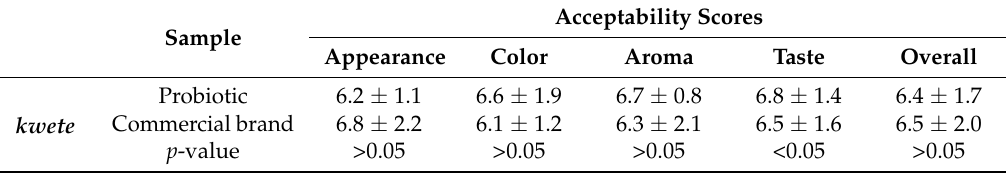
Table 1. Comparison of the consumer acceptability scores of probiotic kwete produced by L. rhamnosus yoba 2012 and S. thermophilus C106 with a commercial brand on a 9-point hedonic scale: 9 = like extremely, 8 = like very much, 7 = like moderately, 6 = like slightly, 5 = neither like nor dislike, 4 = dislike slightly, 3 = dislike moderately, 2 = dislike very much, 1 = dislike extremely. Values are means and standard deviations ( n = 62